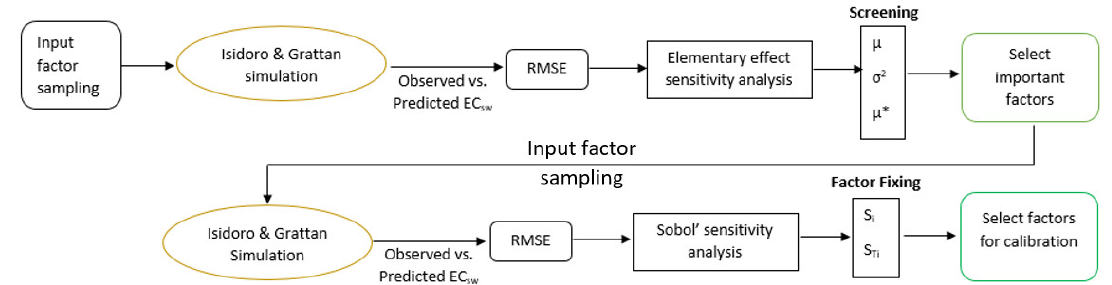
Figure 4. Workflow for calibration of the soil‐water water and salt balance model. Table 3. Model parameters used in the sensitivity analysis. (Note: rz—root zone layers 1–4; 5—